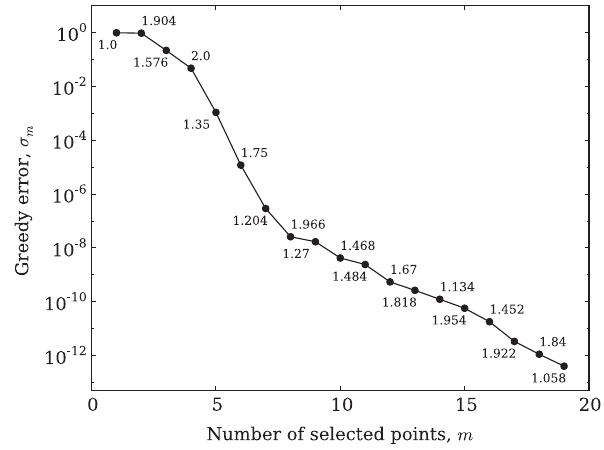
FIG. 3. Greedy error, as defined by Eq. (9), over 501 EOB training set waveforms with mass ratios between 1 and 2. Labels at the dots indicate the selected mass ratios at each step in the greedy